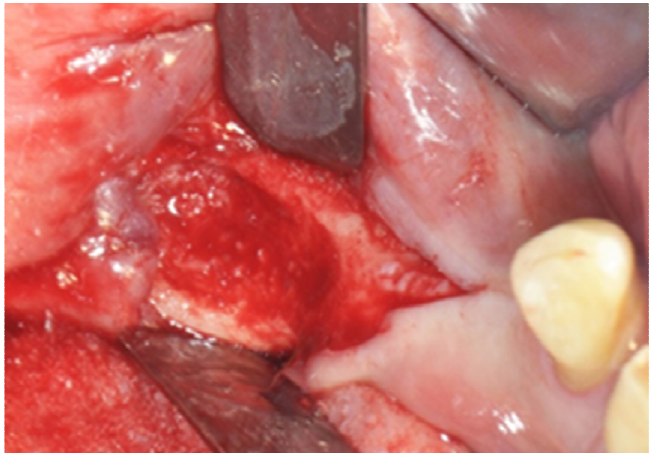
Figure 3. Intraoral intraoperative image of the elevation of the flap to full thickness.